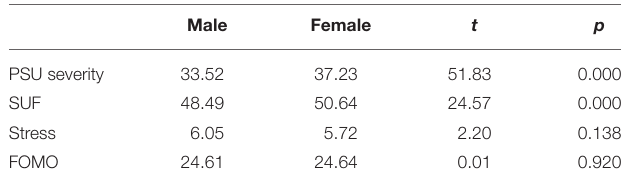
TABLE 2 | T -test for each variable on gender.